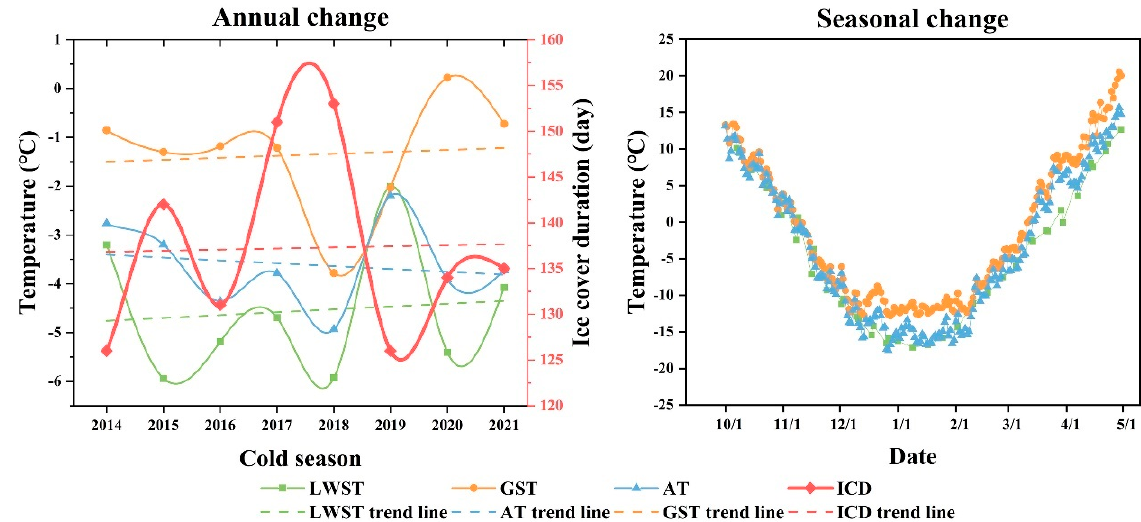
Figure 5. The changes of mean lake water surface temperature (LWST), ground surface temperature (GST), air temperature (AT), and ice cover duration for eight cold seasons from December 2013 to April 2021. The two former were provided by climate satiation, and the last one is derived from remote sensing